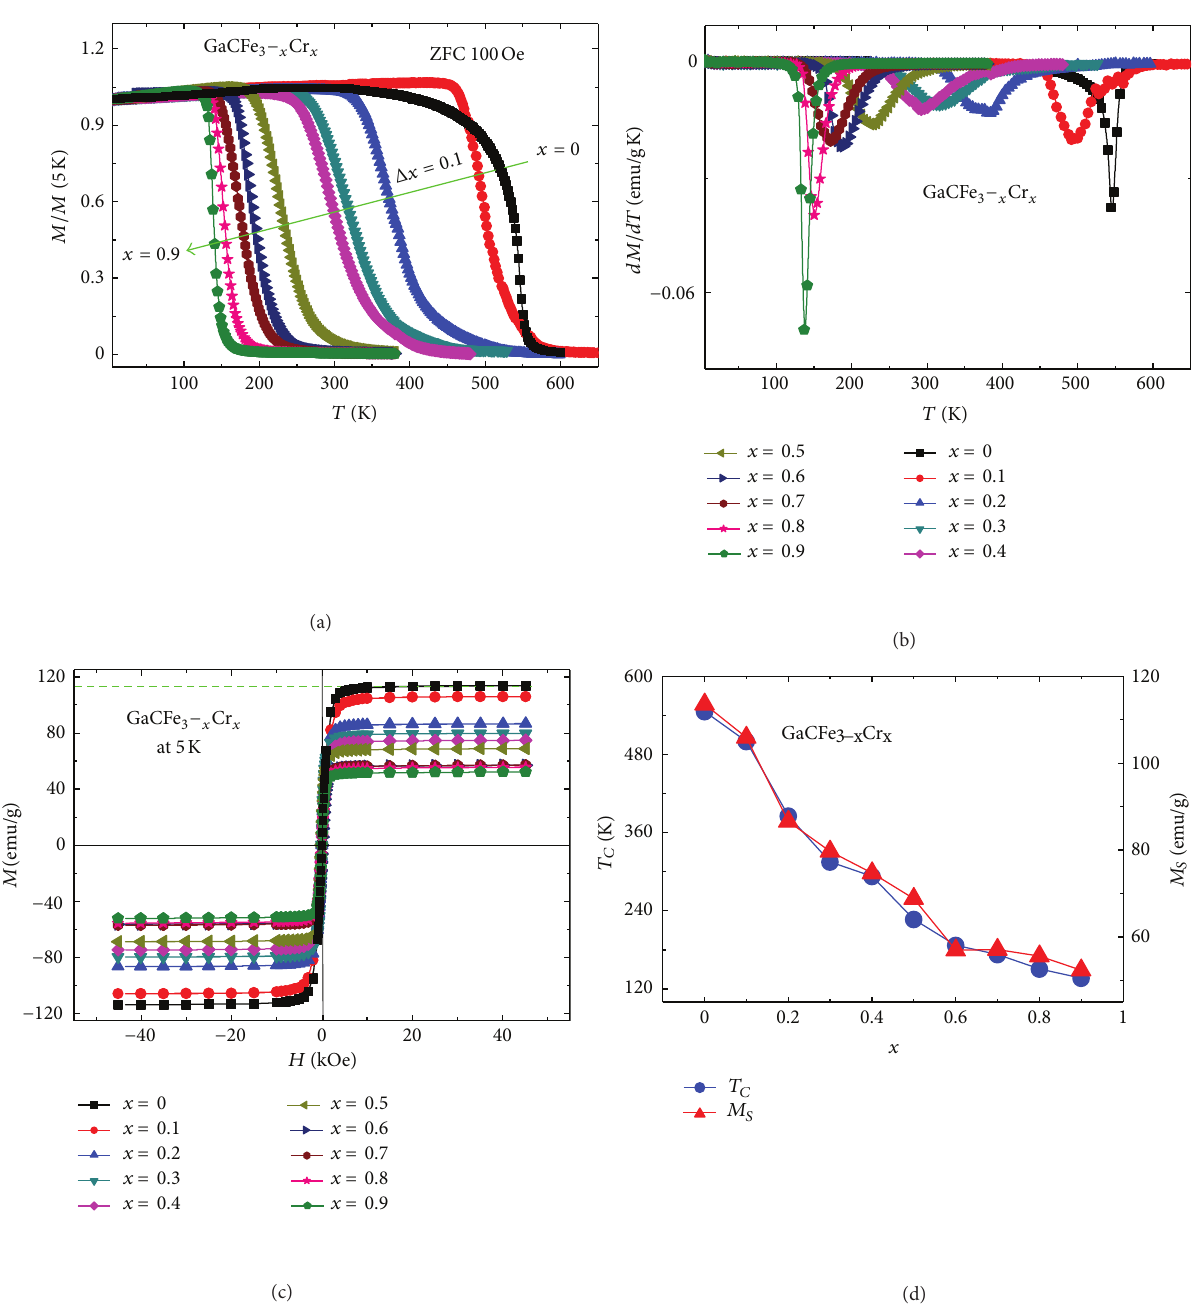
F 2: (Color online) (a) Temperature-dependent magnetization ). (b) Temperature dependence of . (c) Magnetic �eld dependence of magnetization curves